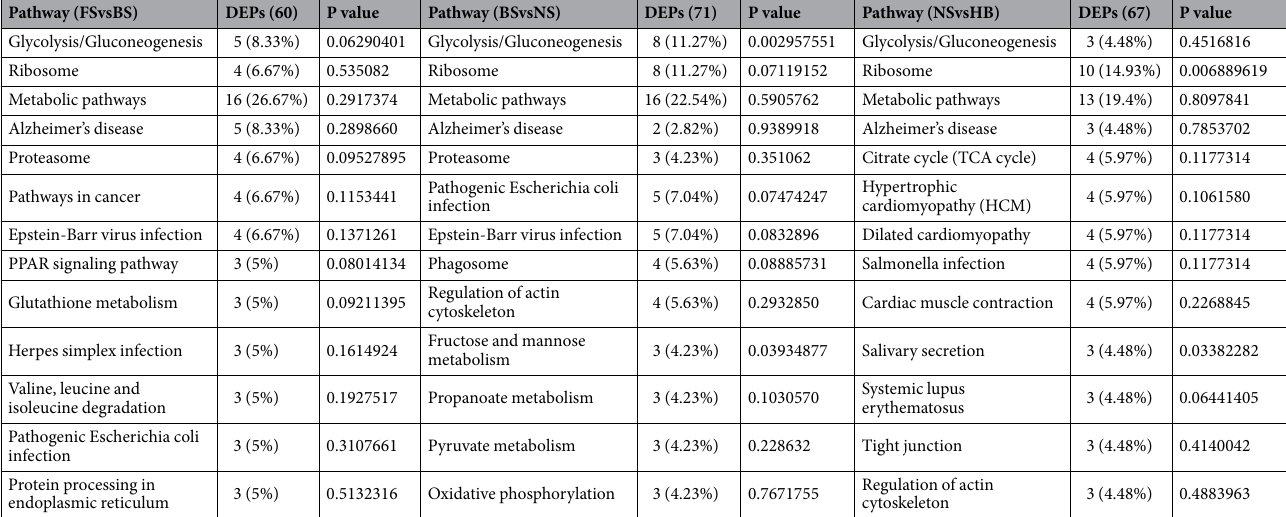
Table 2. Parts of KEGG enrichment pathway. FS: Fertilized egg stage. BS: Blastula stage. NS: Neurula stage. HB: Heart-beating stage.